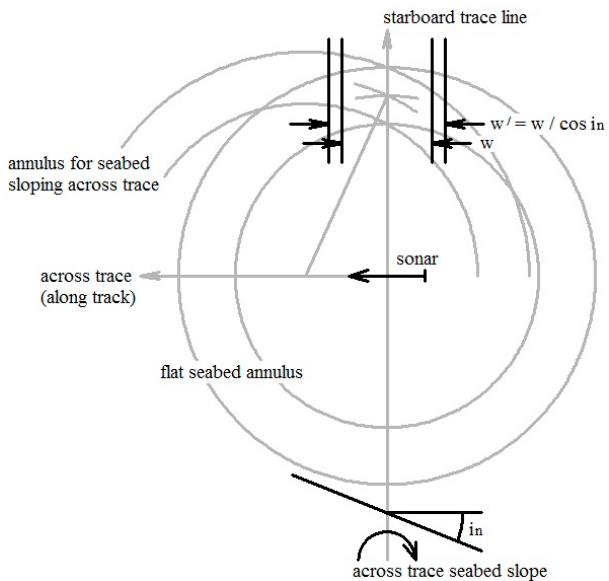
Figure 7. The effect of an across-trace seabed slope on the area of the seabed ensonified for the special case of the seabed slope along-trace being zero. The annulus within which a horizontal seabed is ensonified by the sonar pulse is shown. Part of the annulus ensonified by the sonar pulse for a seabed sloping across-trace projected onto a sloping seabed is also shown. The center of the sloping annulus is offset across-trace (along track) from the sonar. The two annuli share a common line along-trace, and the length of seabed ensonified by the sonar pulse is the same. The inner diverging straight lines represent the width of the seabed ensonified on a horizontal seabed, and the outer lines the width on the sloping seabed.